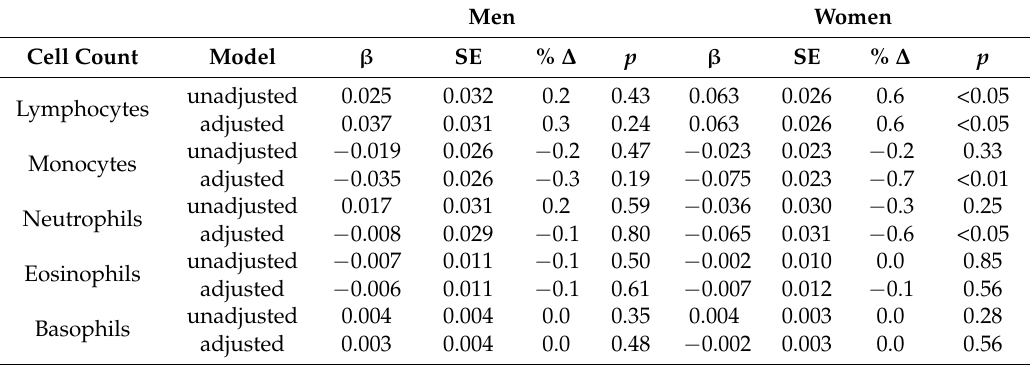
Table 5. Multiple regression models of serum LDL-C predicting changes in peripheral blood leukocyte counts between men and women in NHANES